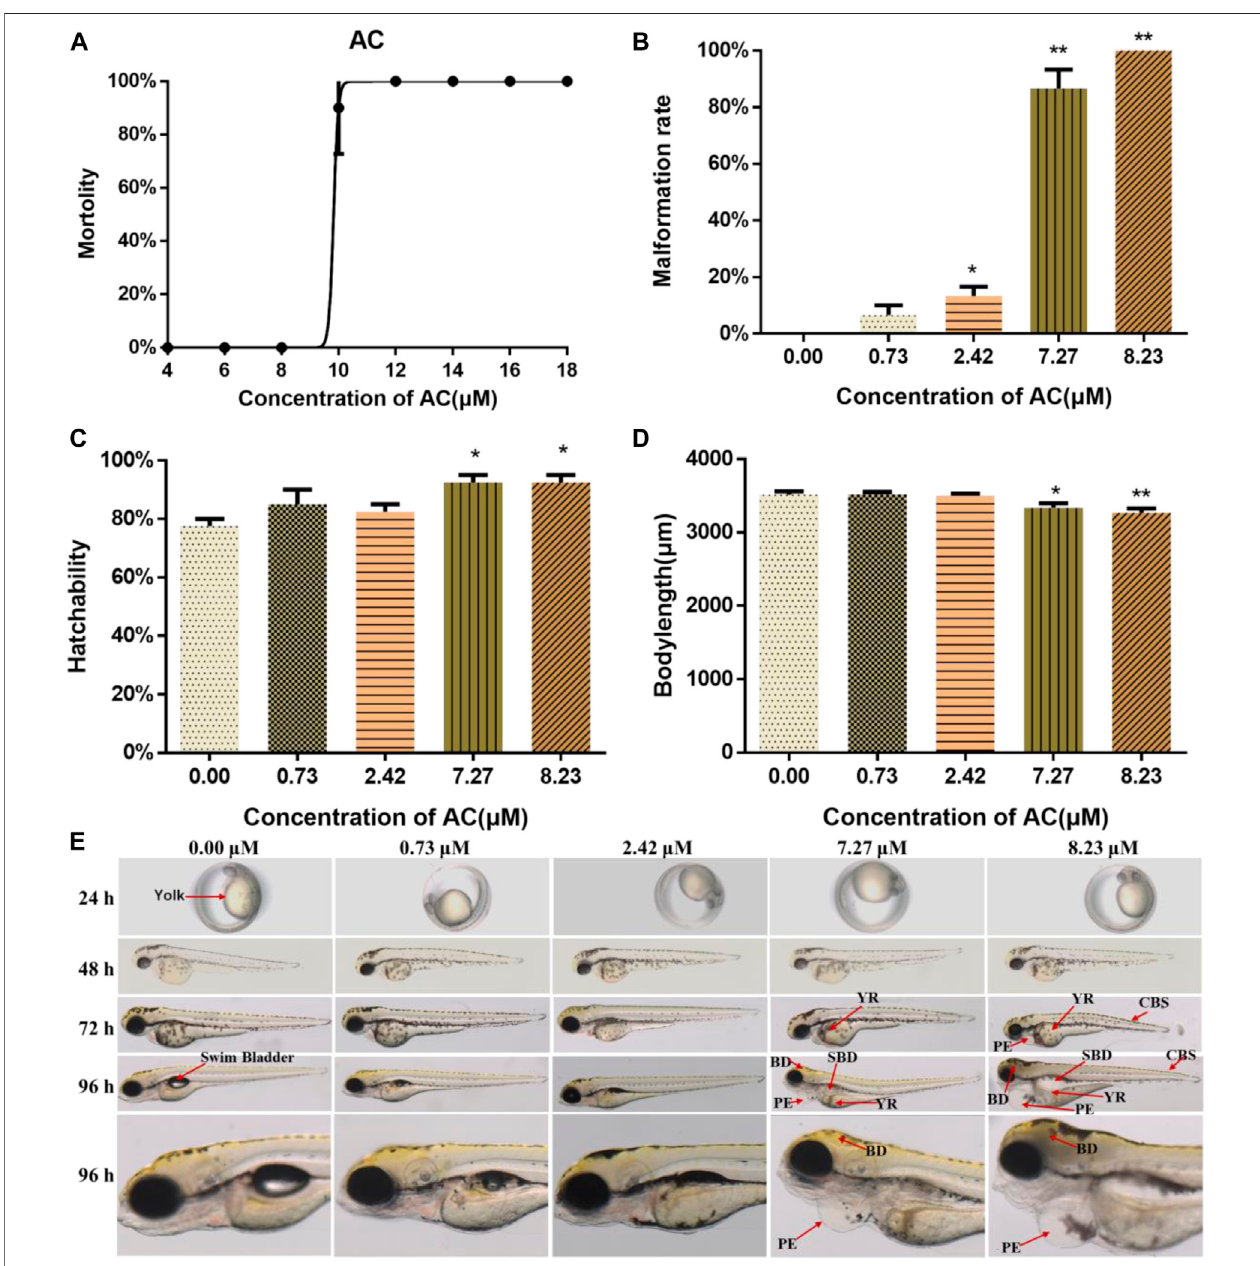
FIGURE1| Lethalandteratogeniceffects ofACinzebra fi shlarvae. (A) Mortality-concentrationcurve. (B) Malformationratesat 96hpf. (C) Hatchability ofembryos at72hpf. (D) Bodylengthat96hpf. (E) TeratogeniceffectsofAConembryophenotypefrom24to96hpf.BD,brainde fi ciency;CBS,curvedbodyshape;PE,pericardial edema;SBD,swimbladderde fi ciency;YR,yolkretention.Thevaluesareexpressedasmean ± SD( n (cid:1) 3,whichmeansthreepoolsof10larvae).* p < 0.05and** p < 0.01 vs. control.